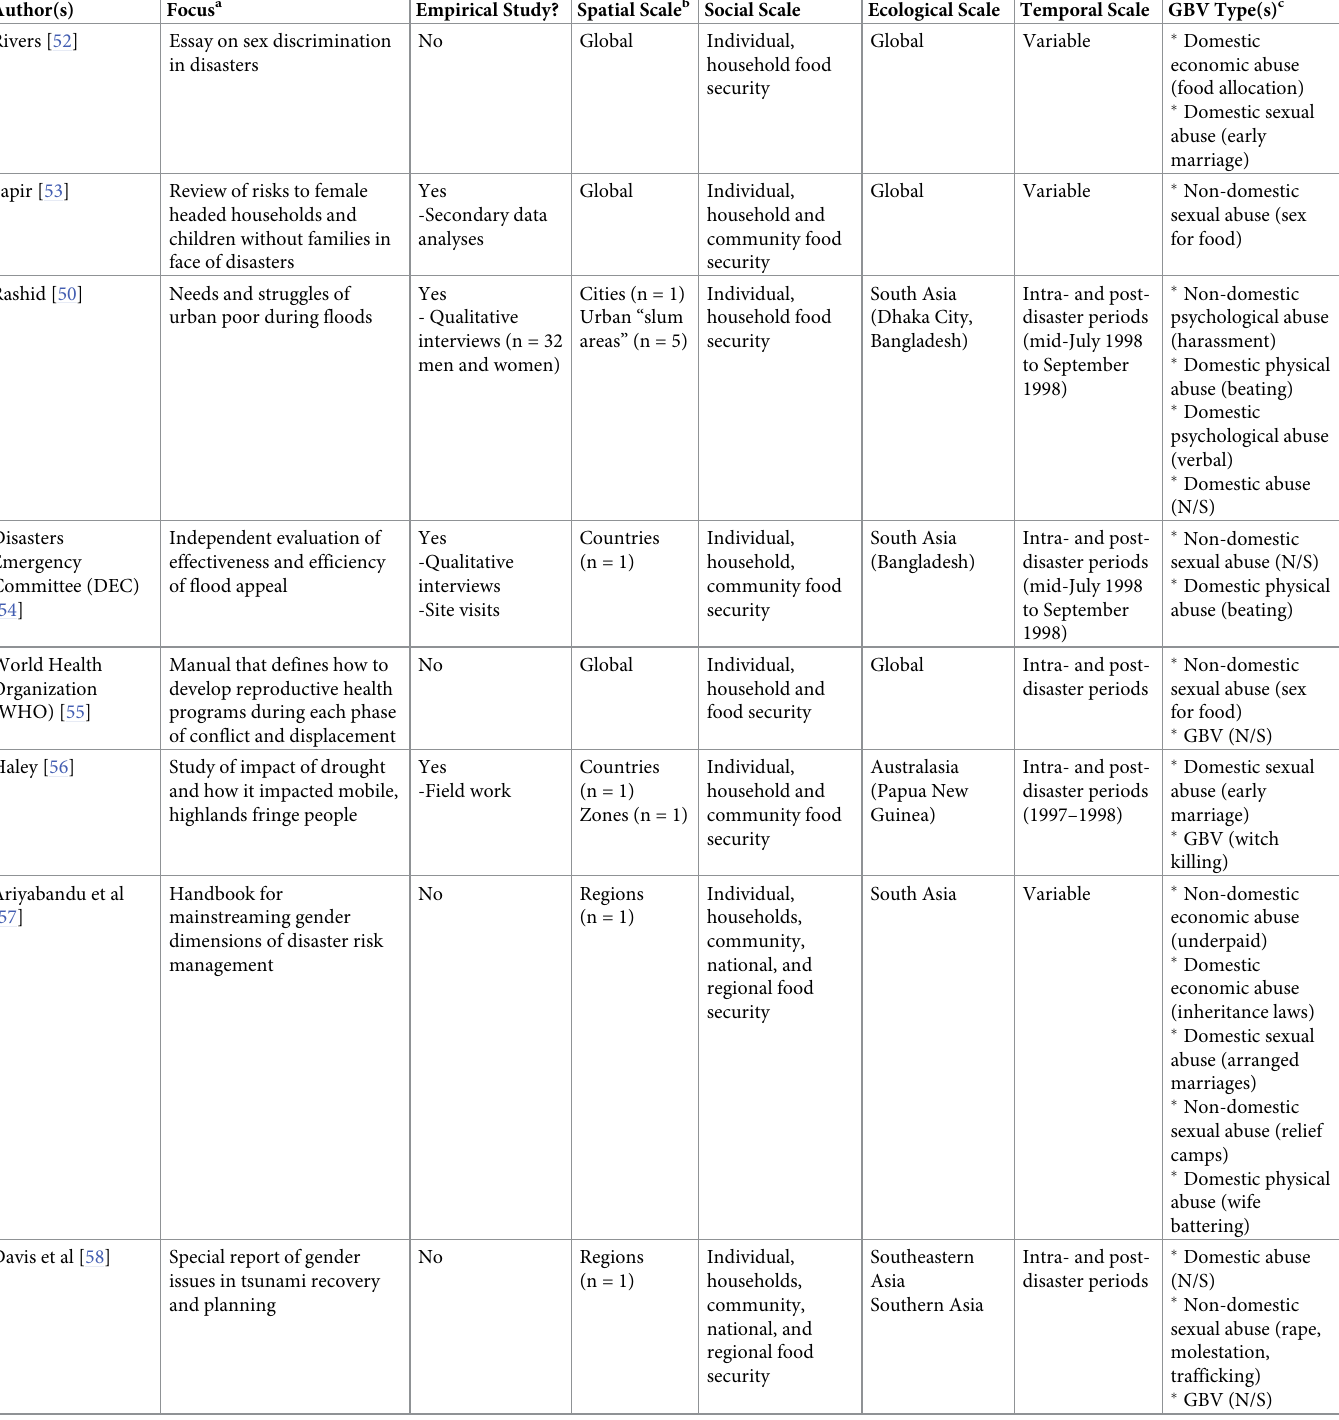
Table 1. Twenty articles identified for scoping review regarding the interrelationship between food security, climate change, and gender-based violence